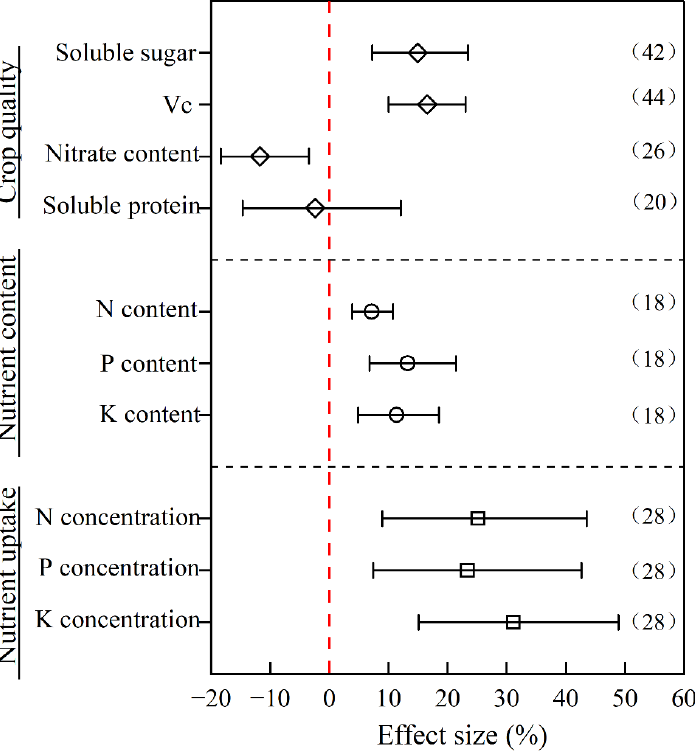
Figure 4. Effect size analysis of various factors on crop quality and nutrient uptake under negative pressure irrigation compared with conventional irrigation conditions. P, phosphorus; N, nitrogen. K, potassium.